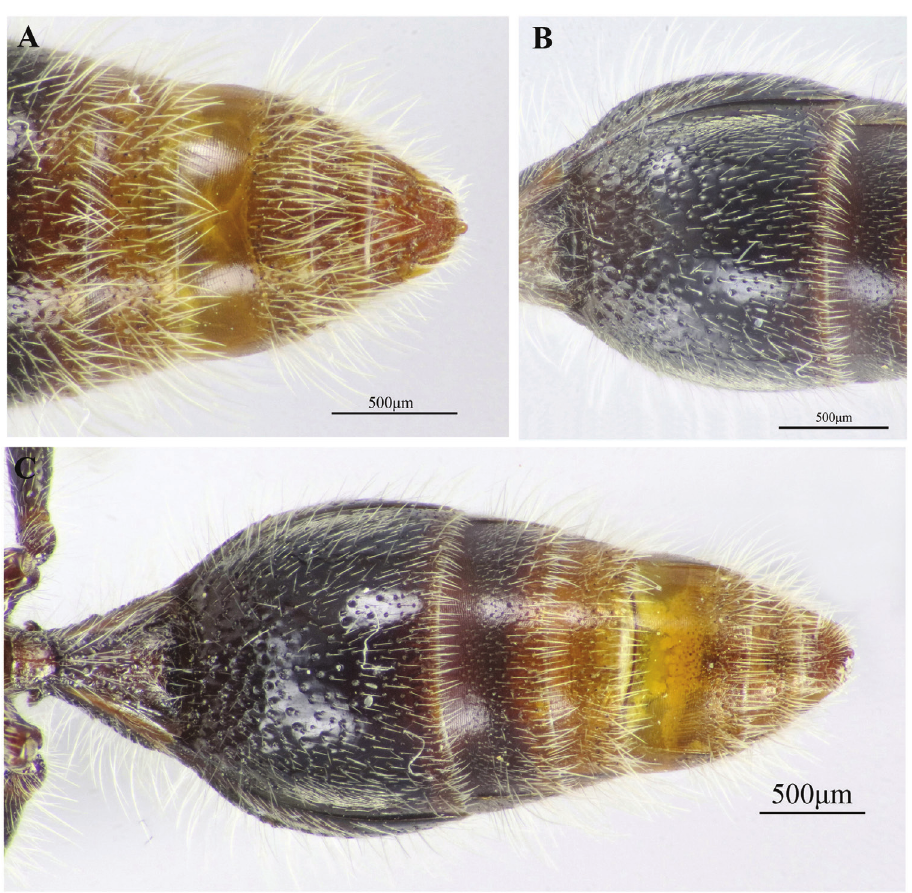
Figure 32. Pseudophotopsis subaurea sp. nov. (Male) A T4–T7, dorsal view B 2 nd metasomal segment (ventro-lateral view) C metasoma, ventral